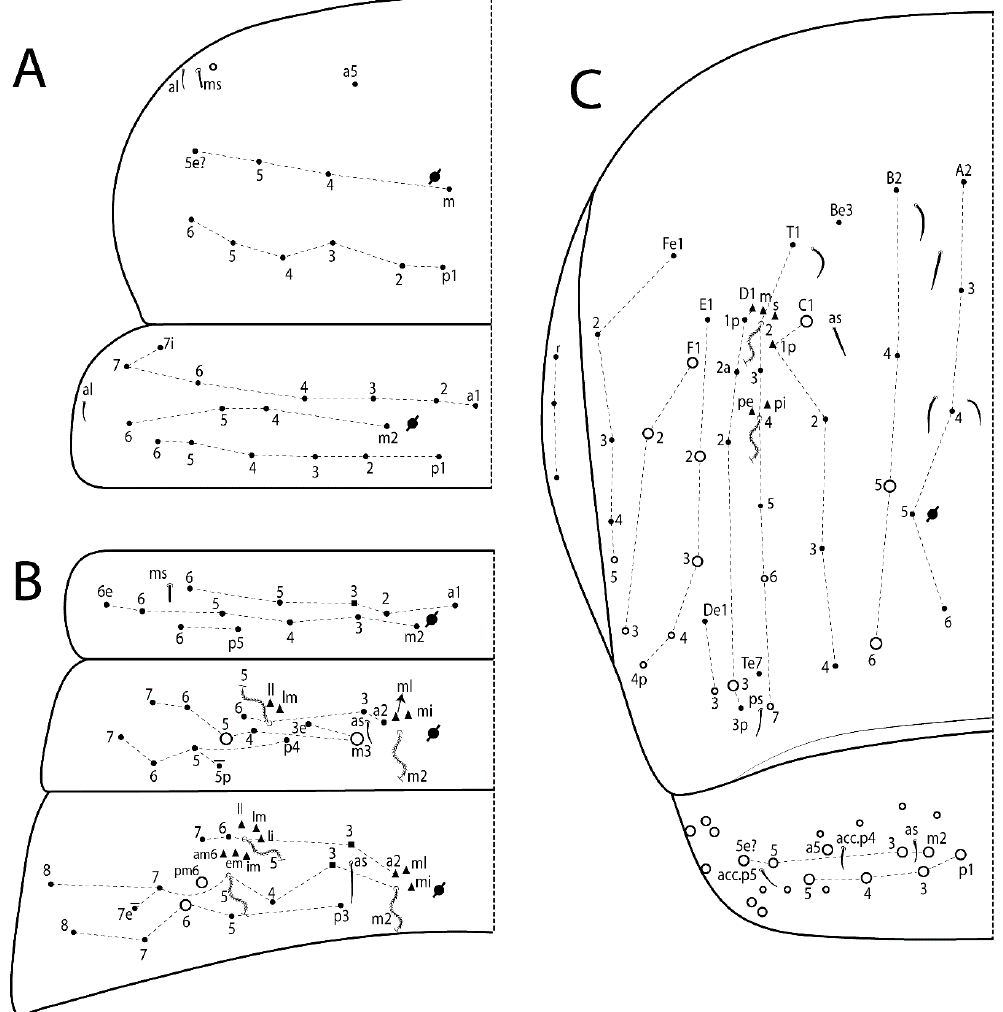
Figure 76. Pseudosinella phyllunguiculata sp. nov.: dorsal chaetotaxy. ( A ) Th II–III; ( B ) Abd I–III; ( C ) Abd IV–V.